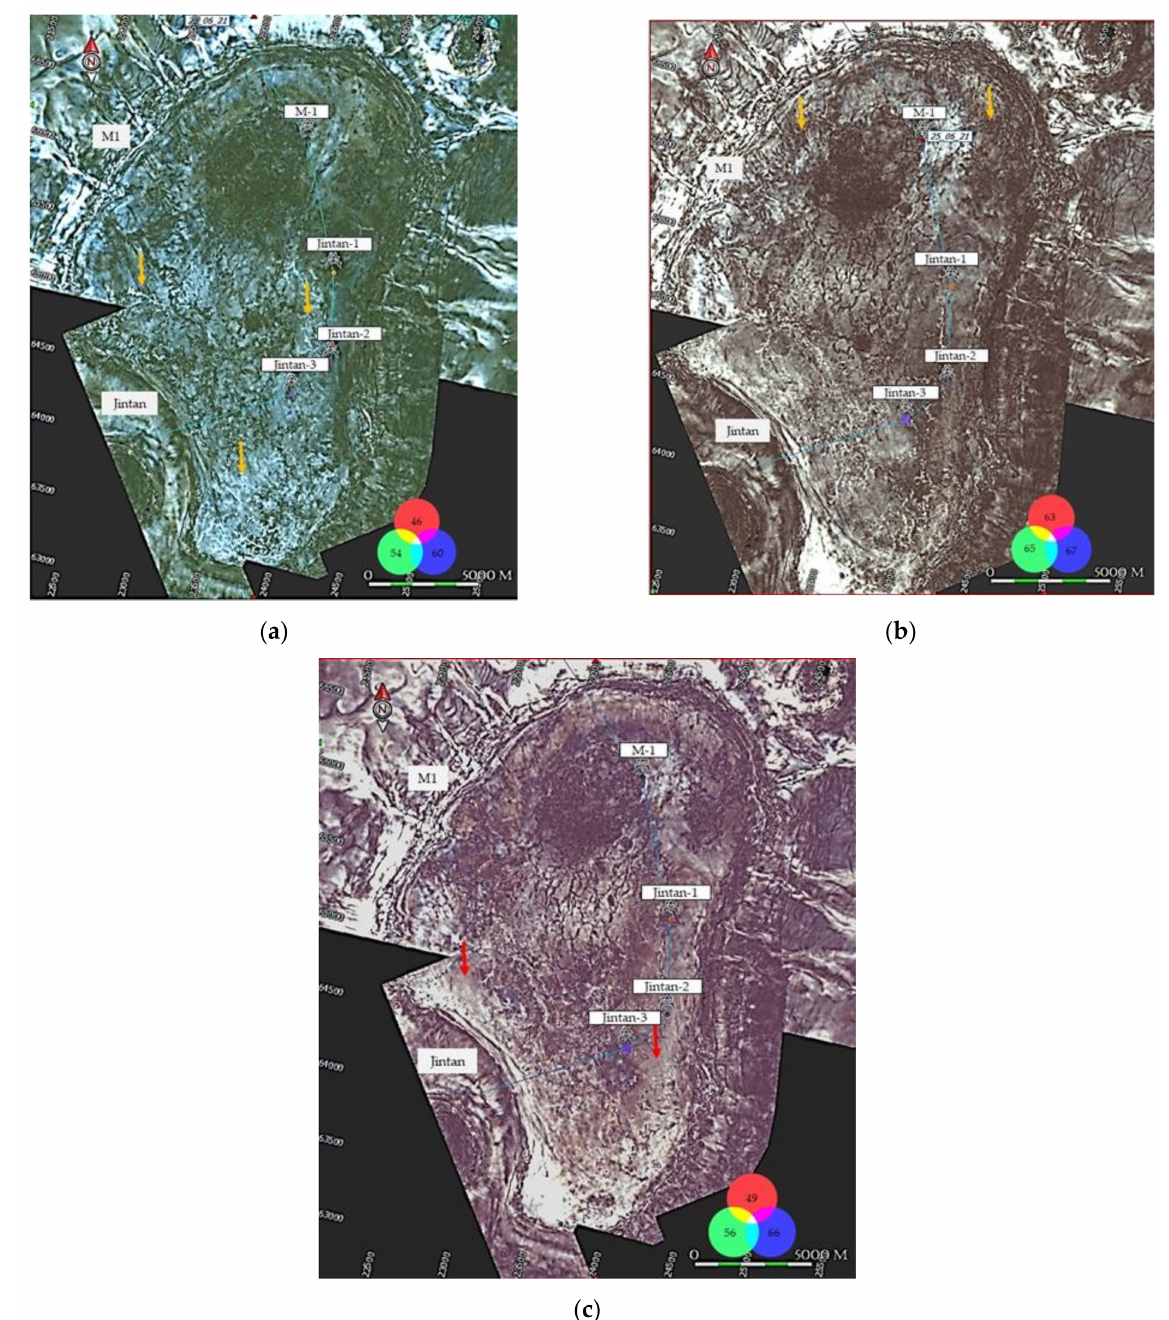
Figure 14. ( a ) STFT method delineates the most karst features especially on Jintan platform as highlighted in the yellow arrow. ( b ) CWT Morlet wavelet delineates most karst features in M1 near to the reef rim as highlighted in yellow. ( c ) CWT Ricker wavelet delineates fewer karst features compared to STFT and CWT Morlet where the karst features were missing on the red arrow